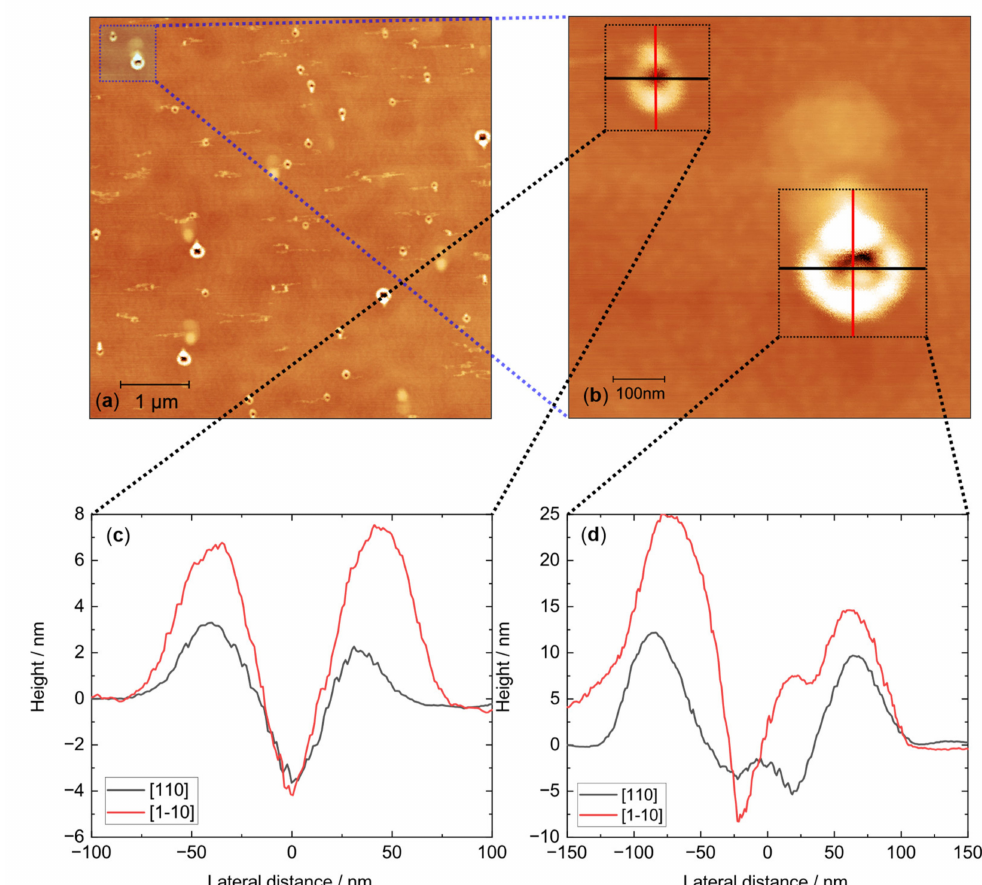
Figure 3. AFM images of the etched nanoholes. ( a ) An overview of the sample surface. A bimodal hole distribution is present, as well as traces of droplet running. ( b ) Representative detailed image of a deep hole ( bottom right ) and a shallow hole ( top left ). ( c ) Height profile of the shallow hole seen in Figure 3b. The shallow holes are 4–5 nm deep, with higher, but not perfect, symmetry. ( d ) Height profile of the deep hole seen in Figure 3b. The deep hole mode etched approximately 10 nm deep with strong asymmetry in the different crystal